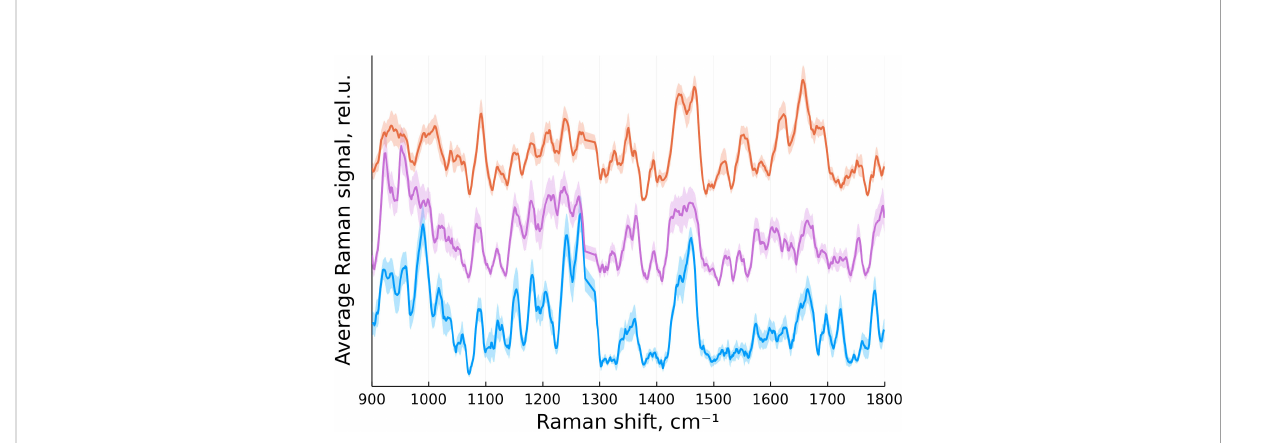
FIGURE 2 Normalized mean Raman signal from normal brain tissue (blue), tumor edge (magenta) and tumor center (orange) with standard error of the mean indicated by a translucent color.